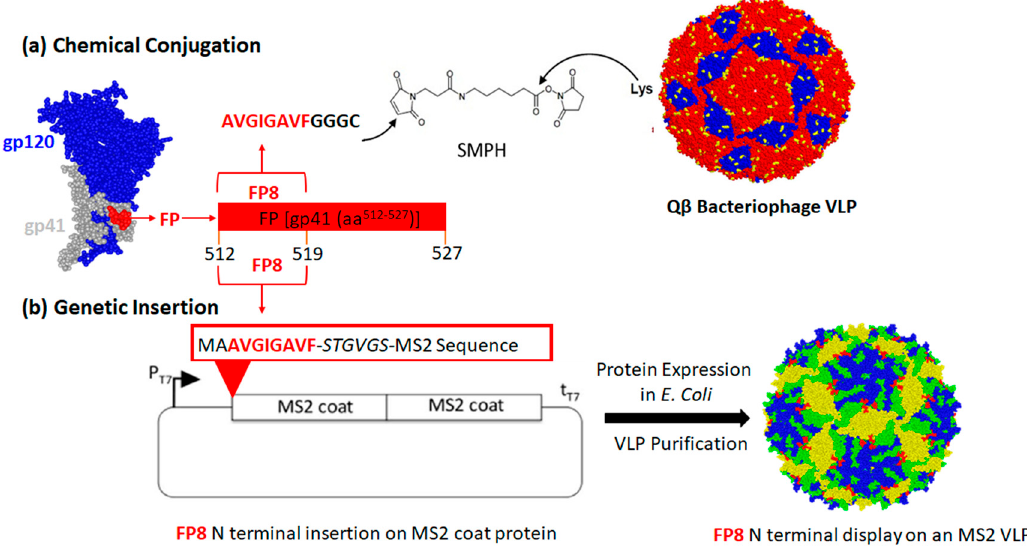
Figure 1. Strategy for displaying the HIV-1 fusion peptide epitope (FP8) on bacteriophage (virus-like particles, VLPs) ( a ) by chemical conjugation or ( b ) by constructing recombinant VLPs. In (a), the FP8 peptide was synthesized to contain a linker sequence with a terminal cysteine residue (-GGGC). The peptide was then conjugated to the surface-exposed lysine (Lys, in yellow) residues on microbially synthesized and in vivo assembled Qß bacteriophage VLPs (dimers formed from A- and B-chains in red, and C-chain homodimers in blue) using a bifunctional crosslinker (SMPH). In (b), DNA sequence encoding the FP8 peptide was inserted into the N-terminus of MS2 bacteriophage coat protein single-chain dimer sequence on an expression vector. Recombinant MS2 VLPs displaying FP8 peptides were expressed from a plasmid in E. coli . The green, blue, and yellow colors on MS2 VLP structure in the figure represent the residues derived from A-, B- and C-chains, respectively. The red color indicates the location of the N-terminal insertion site.